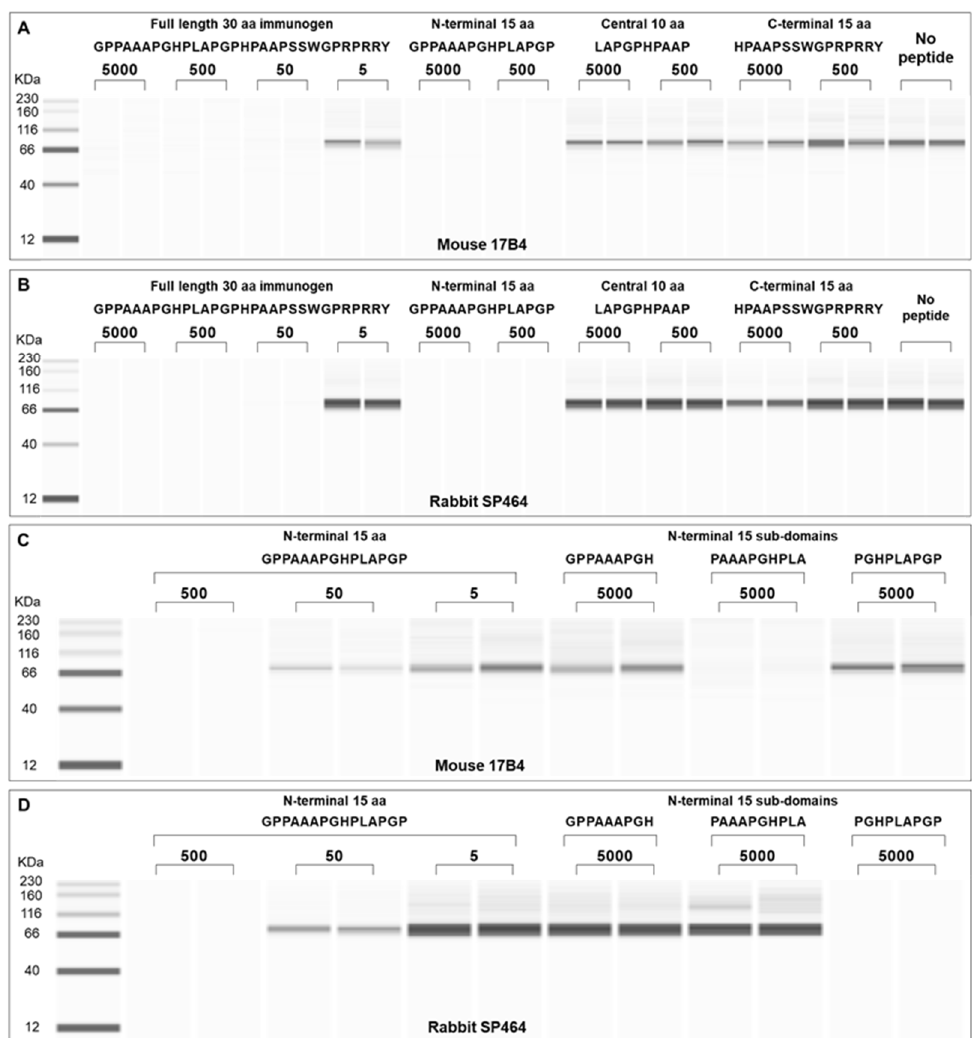
Figure 3. Peptide mapping of epitopes recognized by mouse 17B4 and rabbit SP464 using the ACE assay. Antibodies were incubated with the full-length immunogen or overlapping sequences derived from the N -terminal, central, or C-terminal region. The N -terminal sequence fully inhibits both 17B4 ( A ) and SP464 ( B ). Further fragmentation of the N -terminal sequence with overlapping sub-domain peptides is shown in ( C ) (17B4) and ( D ) (SP464). These panels identify the unique epitopes for each antibody and show complete inhibition with the center sub-domain fragment for the mouse 17B4 and the C-terminal sub-domain fragment for the rabbit SP464.